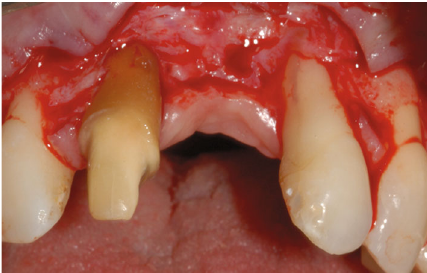
Figure 3: Flap is released (split-full-split) following coronally advanced fl ap design (as described by Zucchelli & De